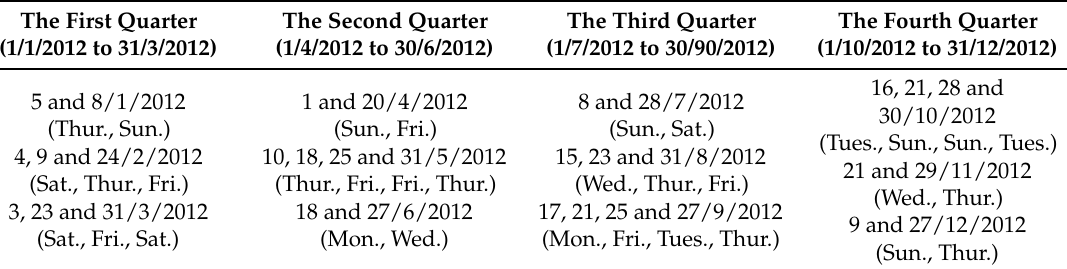
Table 1. The relevant information for each day of the test set.